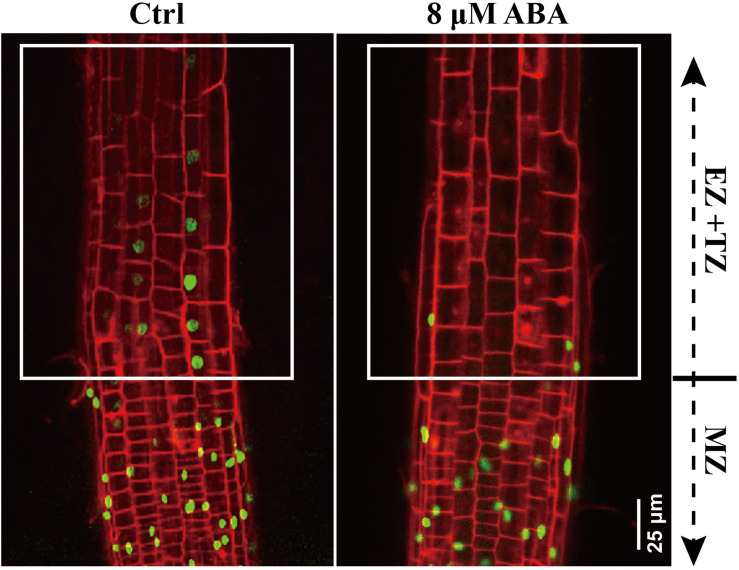
DR5:VENUS signaling in control and ABA-treated seedling. 5-day-old DR5:VENUS seedlings were treated with 8 μM ABA for 1-day. Roots were stained by PI and imaged by confocal microscope. MZ represents meristem zone, EZ and TZ represent the elongation zone (EZ) and transition zone (TZ), respectively. PI is the propidium iodide.